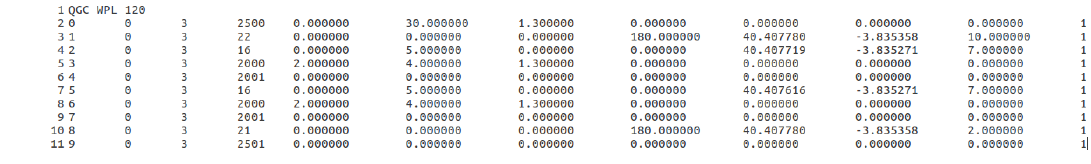
Figure 6. Mavlink